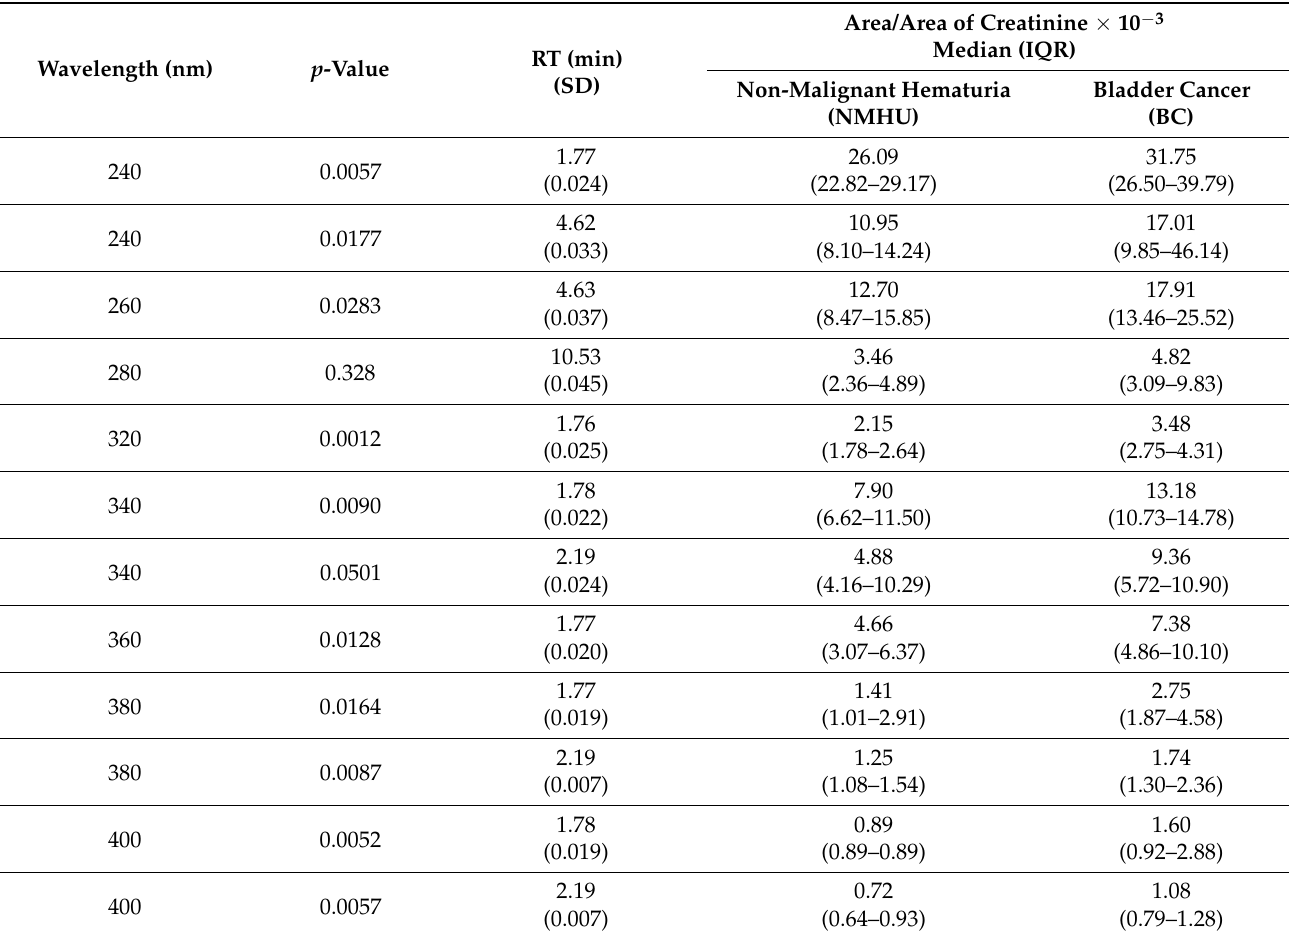
Table 4. Characteristics of absorption peaks identified as significantly different for BC and NMHU